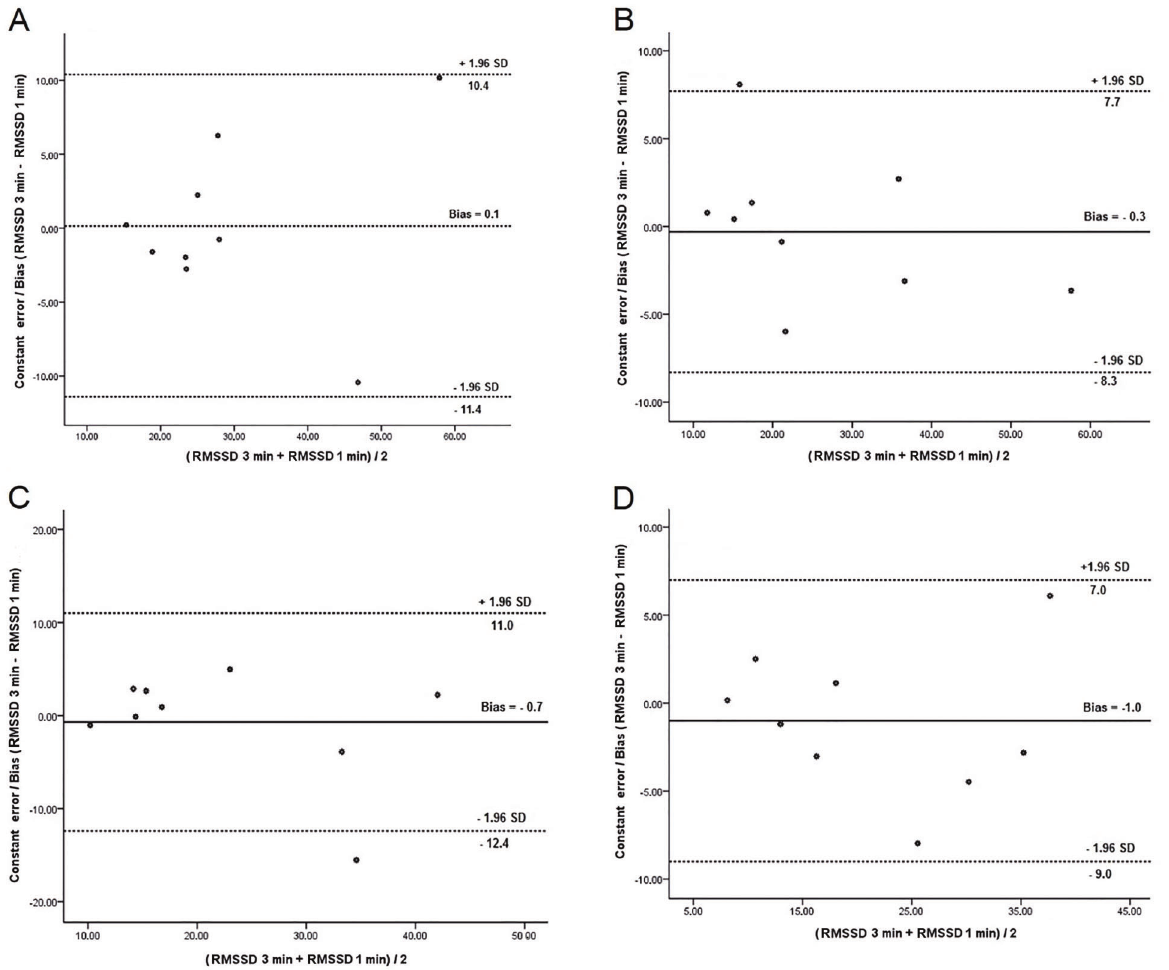
Figure 3. Bland-Altman plots of the differences between RMSSD during 3- and 1-min signals at different resistance exercise loads. A , B , C , and D represent 10, 20, 30, and 35% 1-RM. The solid middle line indicates the bias, while the two dashed lines represent the upper and lower limits of agreement. RMSSD: root mean square of the successive differences. 1-RM: 1-repetition maximum